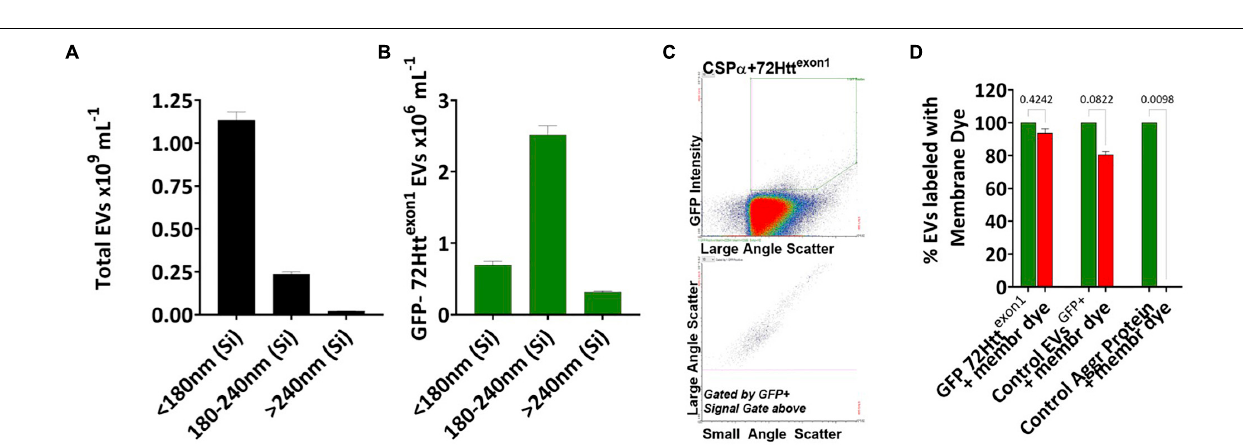
FIGURE 2 | CSP α export of EVs in the 180–240 nm silica range Bar graphs showing the sizes of the (A) total EVs and (B) GFP-72Htt exon1 containing EVs, Silica (Si). (C) Flow cytometry scatter plot of GFP-72Htt exon1 containing EVs. (D) EVs containing GFP-72Htt exon1 , control EVs containing palmitoylated GFP and the control aggregated protein, anti-CD36 FITC, were stained with Deep Red membrane stain. The experiment was replicated 10–12 times, p -values are